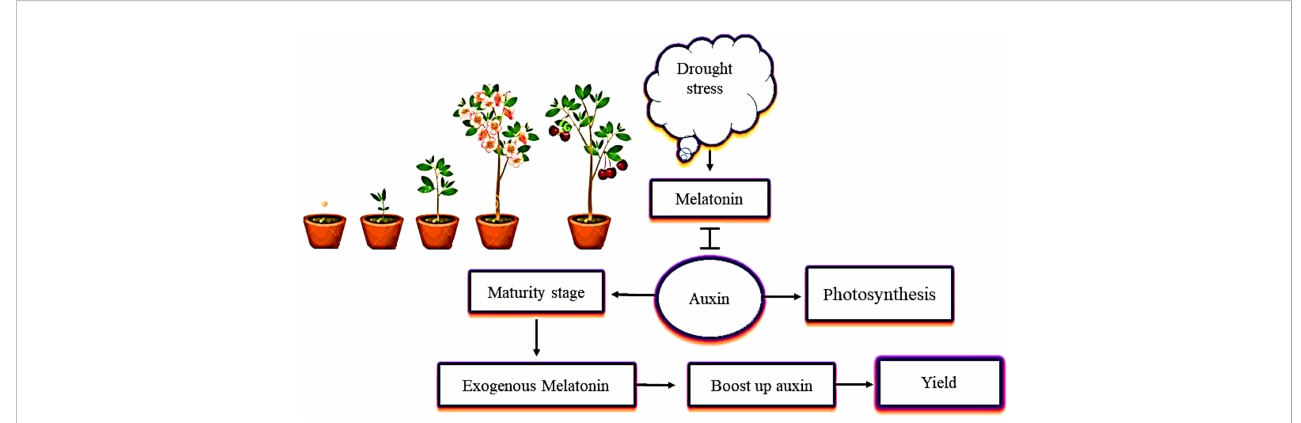
FIGURE 4 The interactive role of melatonin with auxin (IAA, indole-3-acetic acid) in mitigating the effects of drought stress. The application of melatonin increases IAA content in plants. Melatonin and IAA promote plant photosynthetic activity in the same way. When plants are under drought stress, melatonin interacts with IAA at the maturity stage, and increases plant growth and